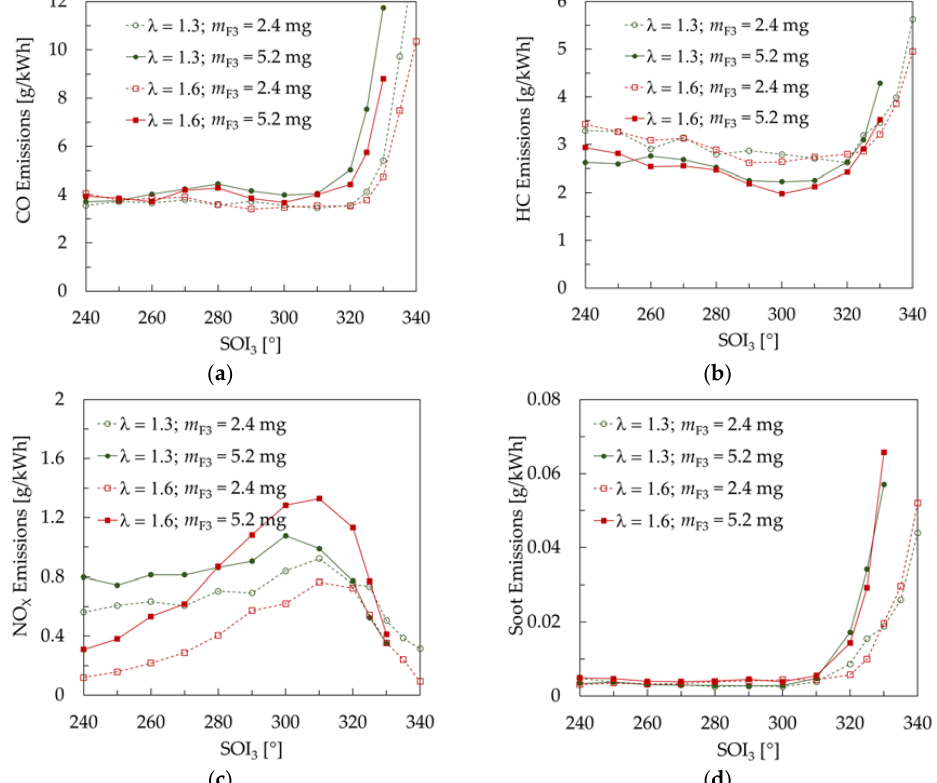
Figure 8. Indicated specific emissions of exhaust toxic compounds versus SOI 3 timing for all investigated conditions: ( a ) CO; ( b ) unburned hydrocarbons (HC); ( c ) NO X ; ( d ) soot.